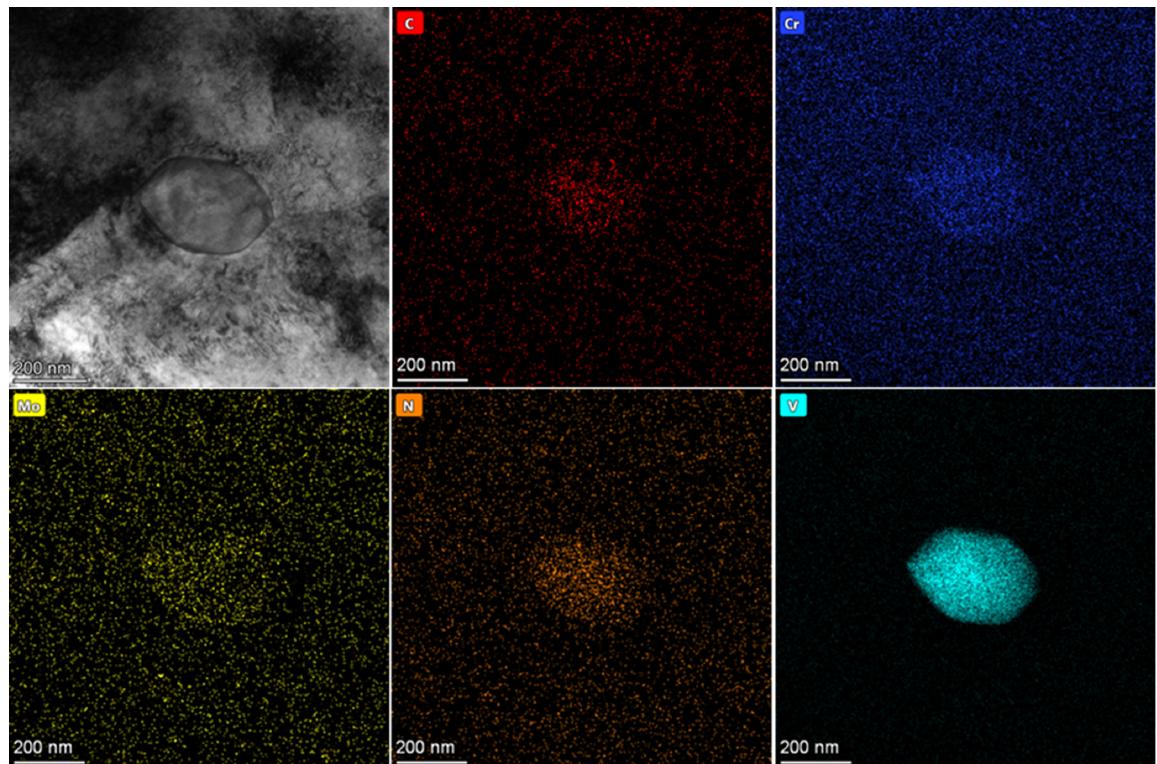
Coatings 2023 , 13 , x FOR PEER REVIEW Figure 6. TEM images of carbon nitride in C + N and the corresponding EDS. Figure 6. TEM images of carbon nitride in C + N and the corresponding EDS.